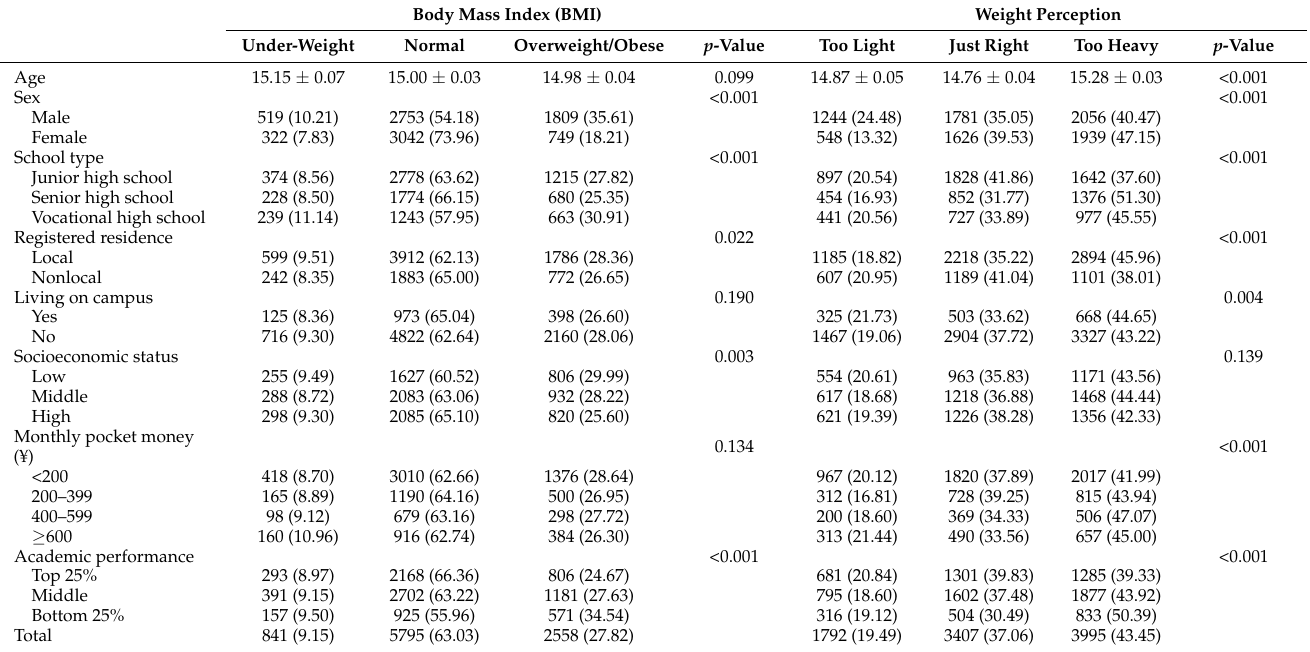
Table 1. Sociodemographic characteristics according to weight-related statuses